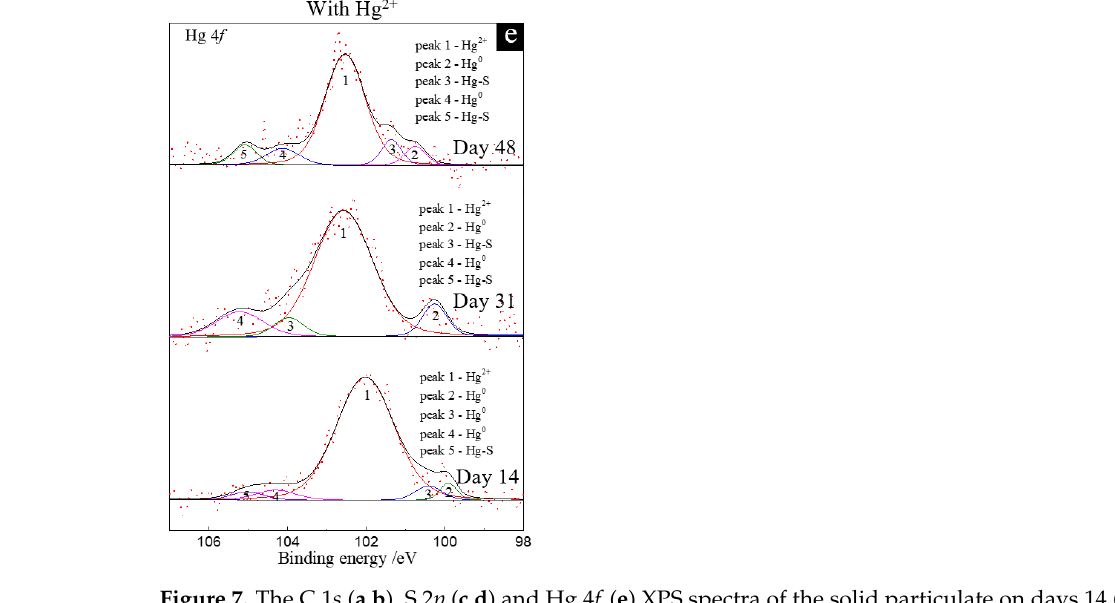
Figure 7. The C 1 s ( a , b ), S 2 p ( c , d ) and Hg 4 f ( e ) XPS spectra of the solid particulate on days 14 ( a ), 31 ( b ) and 48 ( c ) for the groups without ( a , c ) and with ( b , d , e ) Hg 2+ .